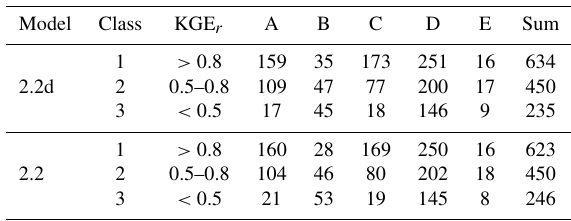
Table 4. Model performance with respect to streamflow timing: number of calibration basins per KGE r category and Köppen– Geiger climate